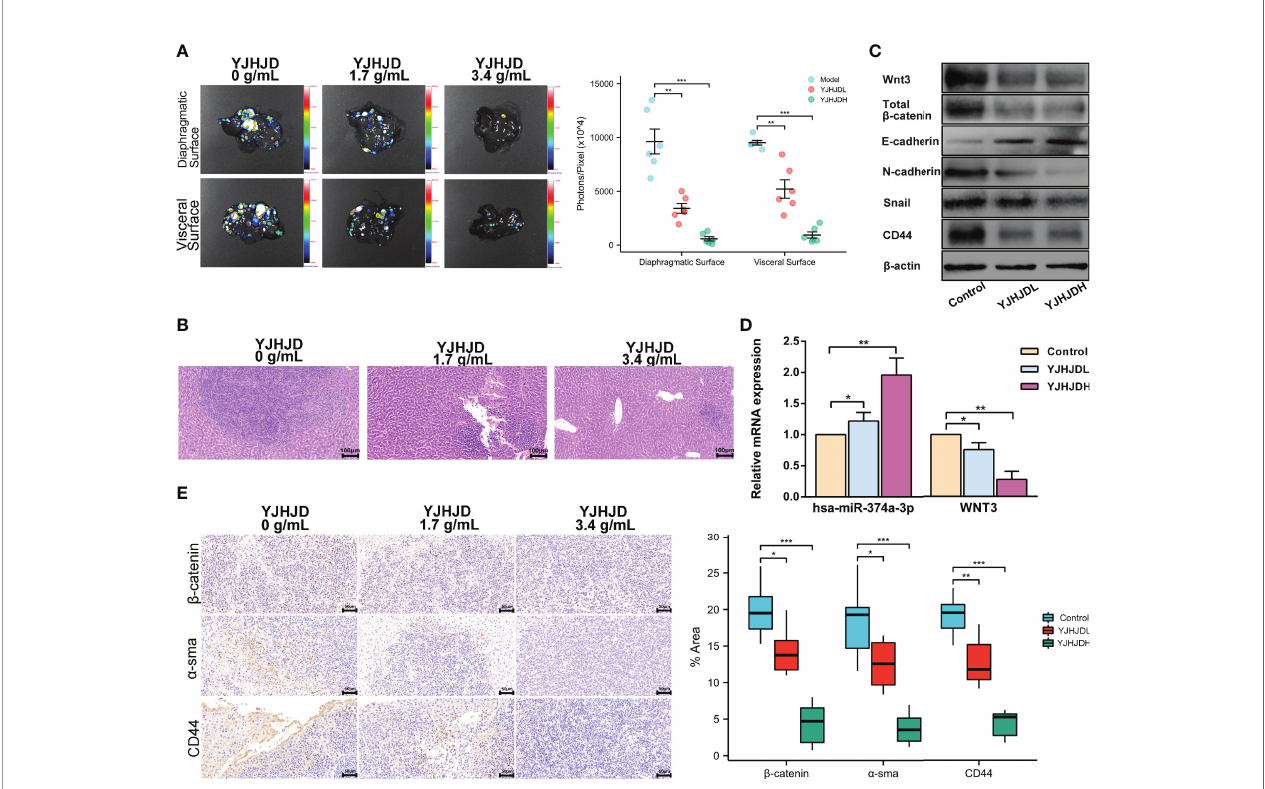
FIGURE 7 | YJHJD restrains liver metastasis of COAD via reversing hsa-miR-374a-3p/WNT3/ b -catenin-mediated EMT and cellular plasticity. (A) Fluorescence intensity on behalf of liver metastases was assessed by the Live Animal Analysis System. (B) Liver metastatic lesions and tumor in fi ltration was evaluated by HE staining. (C) mRNA levels of hsa-miR-374a-3p, WNT3 was tested by PT-PCR assay. (D) Protein expression of WNT3/ b -catenin, EMT, and cellular plasticity relevant molecules was studied through Western blot assay. (E) Expression of b -catenin and a -sma in the liver metastatic tumor tissues was examined via IHC analysis. *P <0.05, **P < 0.01, *** P < 0.001 compared to control